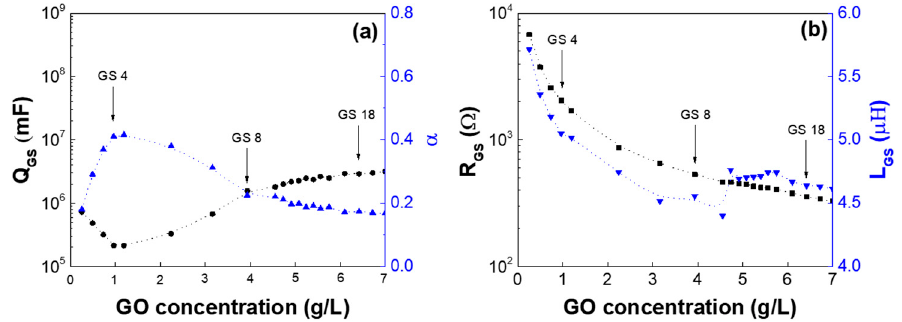
Figure 7. GS circuit component parameters: ( a ) constant phase elements ( Q GS ) with the index of α , and ( b ) L GS and R GS as a function of frequency. Table 2. Component values of various GSes.